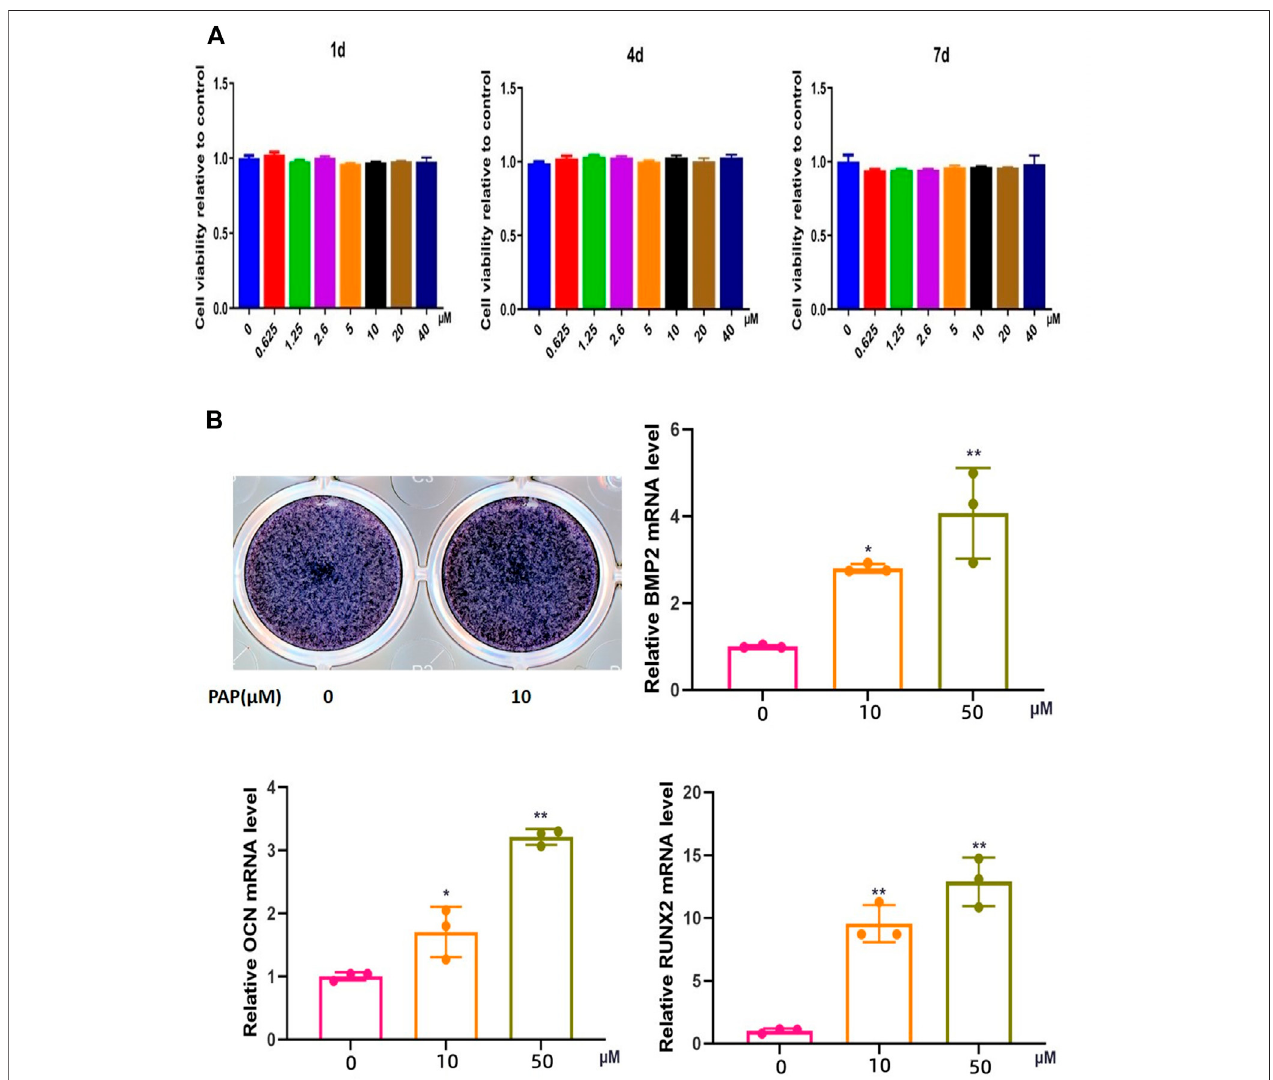
FIGURE 2 | Cytotoxicity of and osteogenesis promotion by polypeptide PAP. CCK-8 assay results on (A) 1,4, and 7 d of exposure of rat bone marrow- derived mesenchymal stem cells (BMSCs) to lipopolysaccharide (LPS) and/or PAP (B) ALP staining and RT-qPCR of osteogenesis-related genes in rat BMSCs. **p < 0.01, *p <